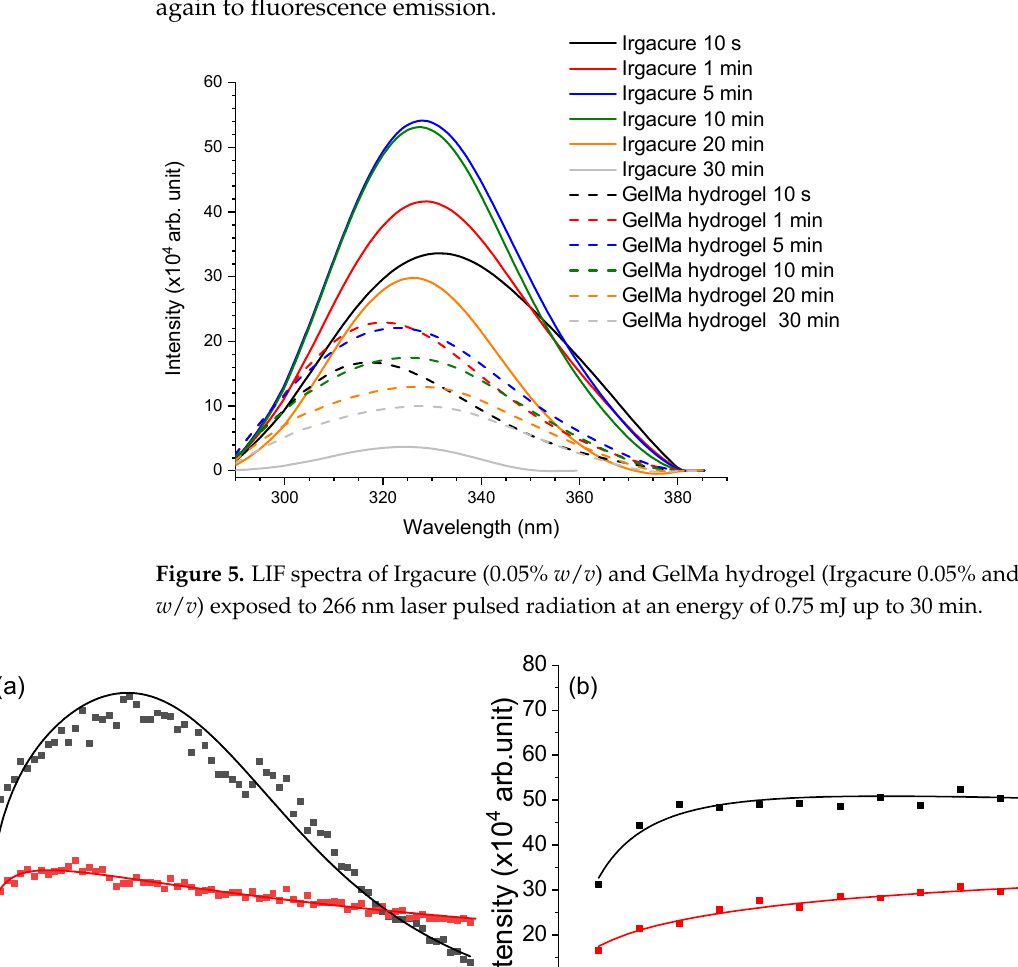
two radicals, they recombine before they dissociate by diffusion being susceptible once